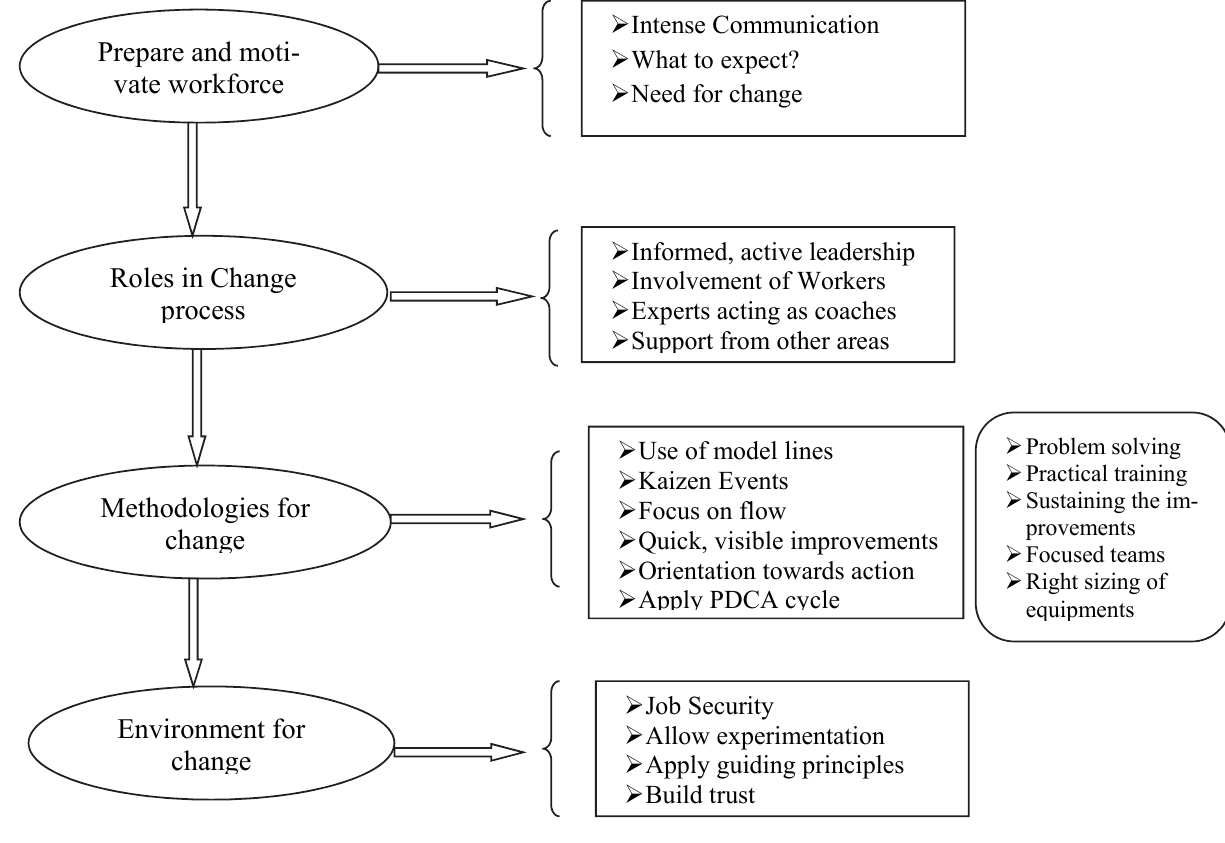
Fig. 1. Success factors for lean manufacturing (Duque & Cadavid,